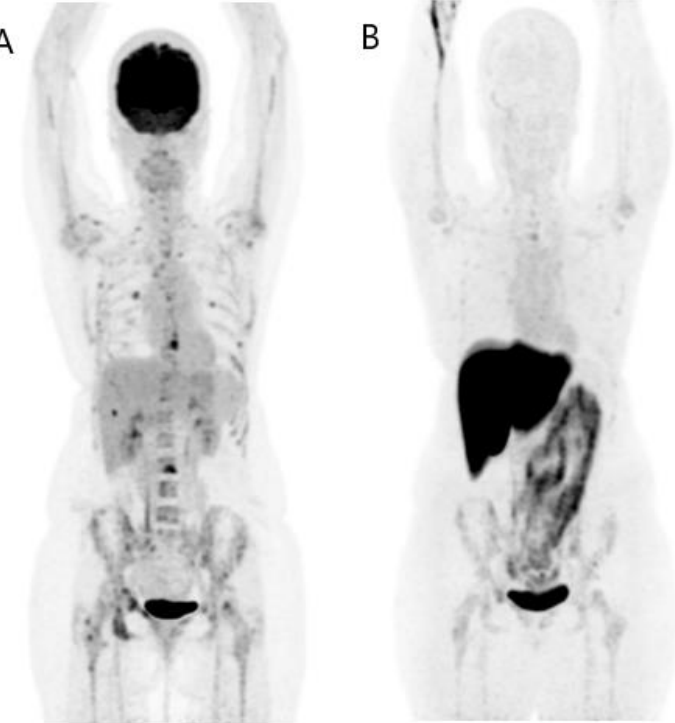
Figure 7. FES PET/CT in treatment guidance. A 48-year-old woman was diagnosed with bifocal BR 12 years ago and treated with surgery, chemotherapy, and radiotherapy. In the primary breast tumor, there were two contingents: one was HER2- RH- and another was HER- RH+. A recurrence was detected by FDG PET/CT ( A for MIP image). A FES PET/CT was also performed ( B for MIP image) and was negative. Finally, treatment with eribuline was preferred to palbociclib–fulvestrant because the latter would probably be